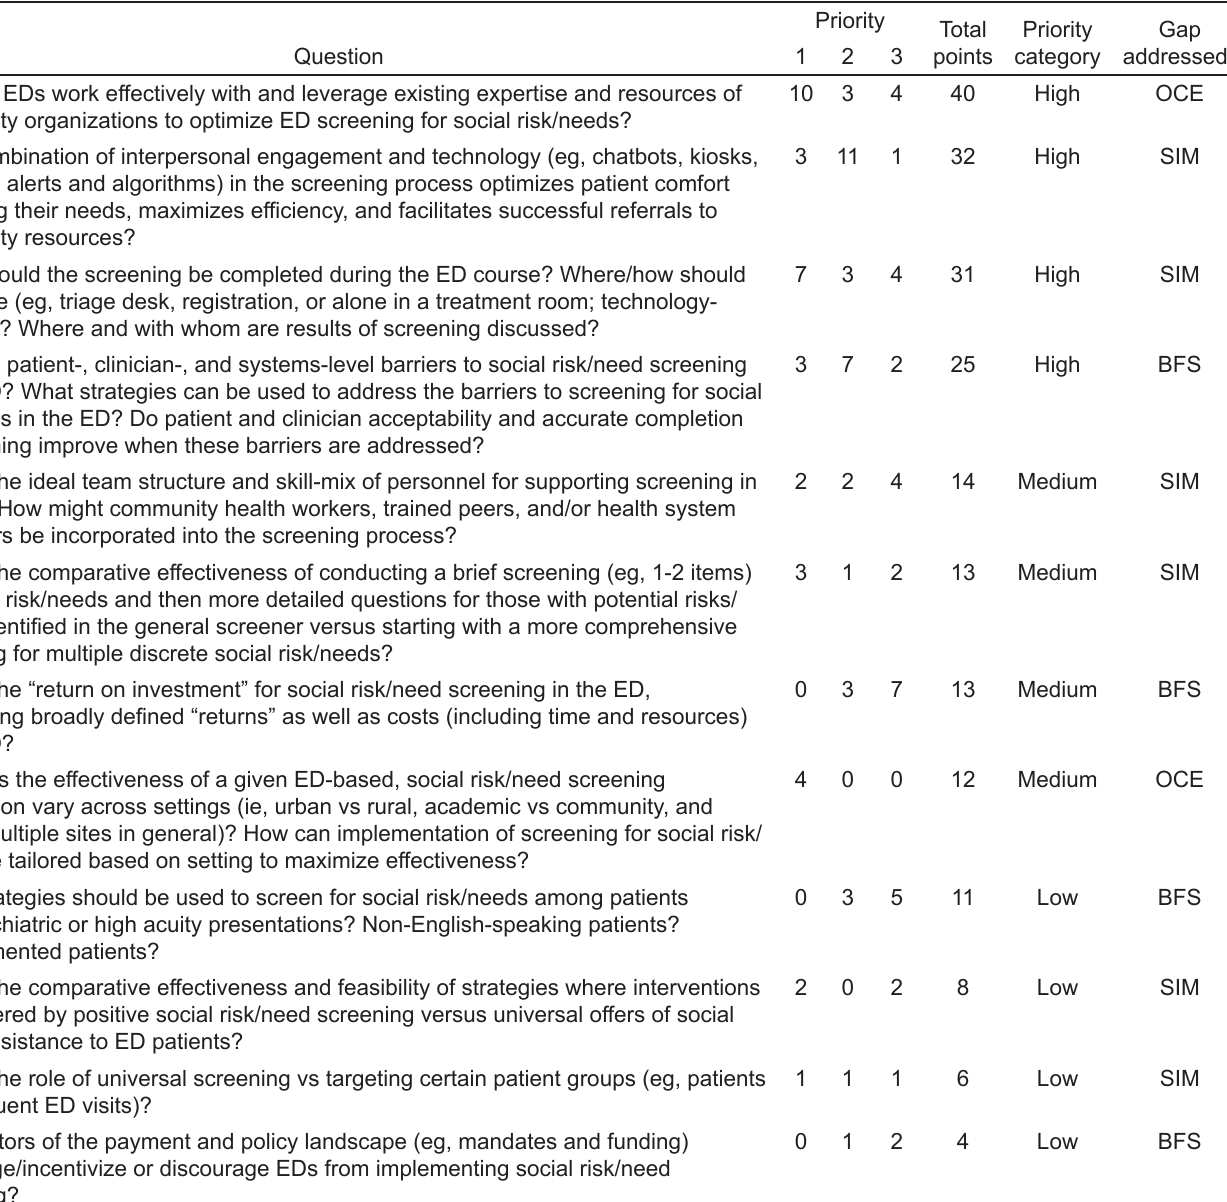
Table. Final ranked research priorities pertaining to implementation of social risks and needs screening in the emergency